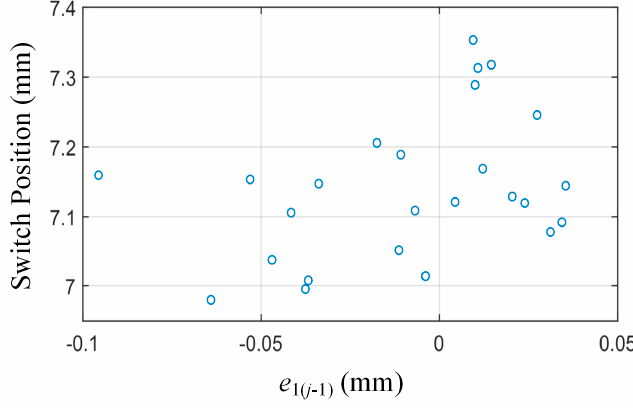
Figure 20. The compression stroke switch position.